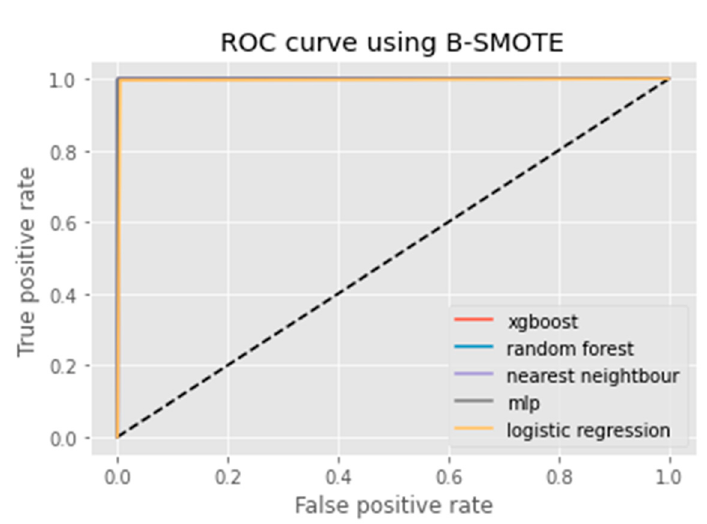
Figure 5. ROC curve using ADASYN.